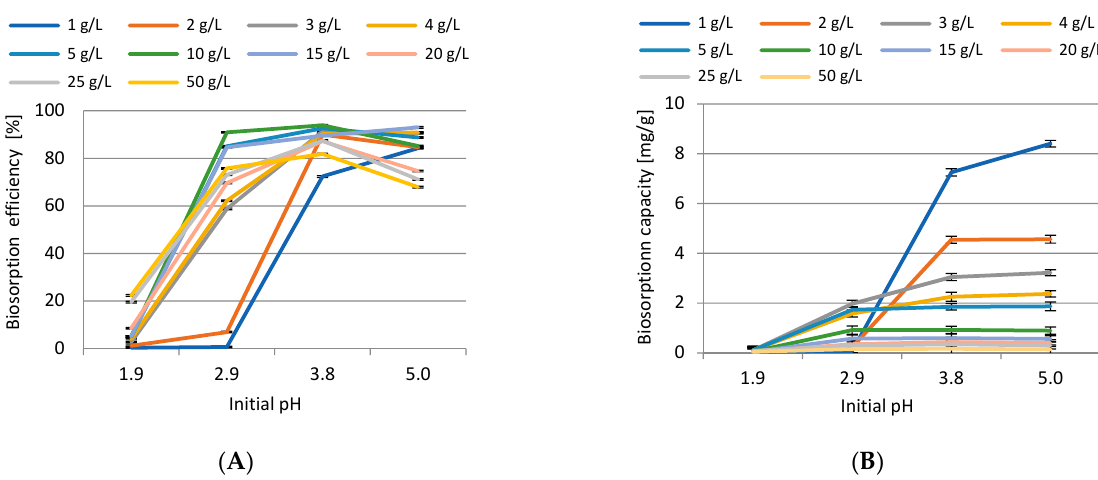
Figure 13. The impact of initial pH on removal efficiency (A) and biosorption capacity (B) of Cd(II) ions.